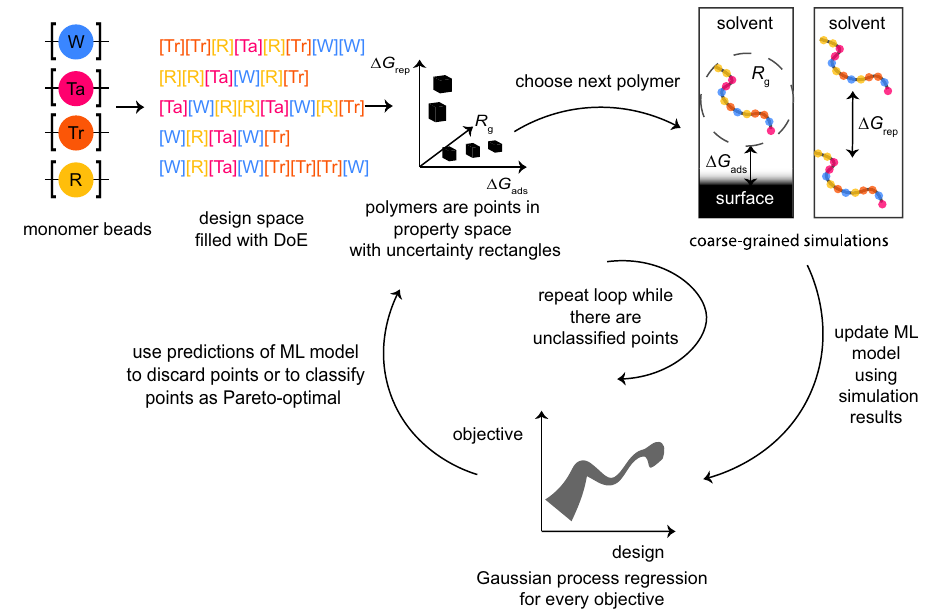
Fig. 1 Overview of the work fl ow. Using classical design of experiments (DoE), we enumerate representative samples in the design space of monomer sequences, which we then explore in the active learning loop with the ϵ -PAL algorithm. For this algorithm, Gaussian process surrogate models provide us with predicted means and standard deviations (SDs) that enable us to decide which designs we can con fi dently discard, classify as Pareto optimal, and determine which simulation we should run next to maximally reduce the uncertainty for points near the Pareto front. Models that are trained over the course of this process can reveal structure – property relationships and can be inverted using genetic algorithms to further explore the design